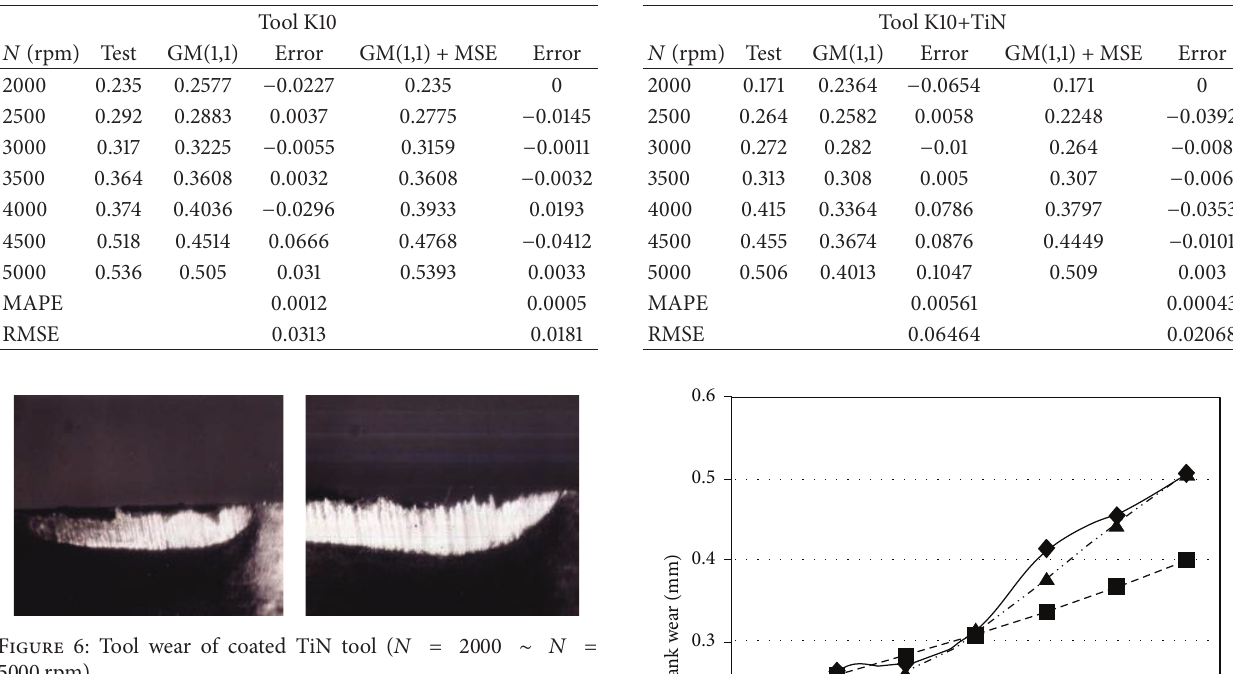
Table 2: Comparison sheet of the common and improved grey prediction model.